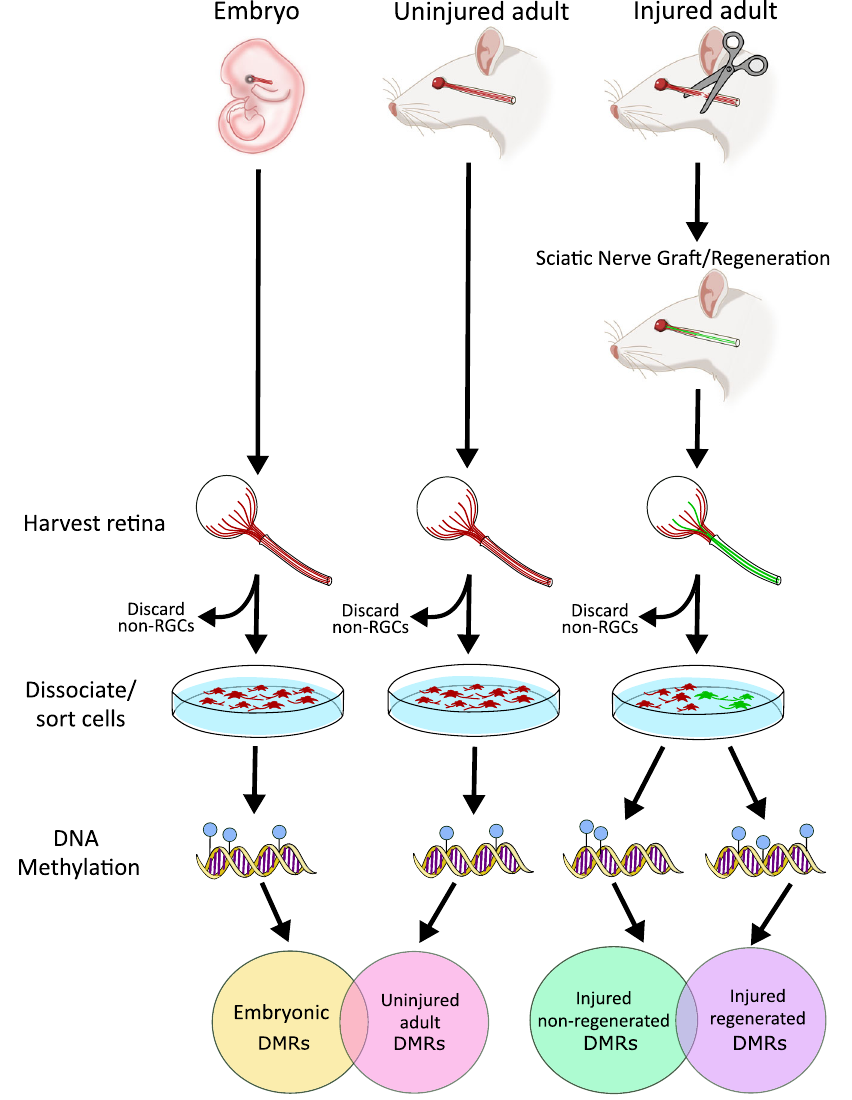
Fig. 1 Overview of the experimental design. A visual fl owchart depicts the overall design of the experiments reported in this article. The fi rst column depicts experiments using uninjured embryo (UE) retinal ganglion cells (RGCs). Embryonic retinas were harvested and dissociated, then FACS-sorted and sorted into RGCs (stained red) and non-RGCs (unstained). The non-RGCs were discarded. DNA was extracted from sorted RGCs and whole-methylome sequencing was performed. The second column depicts experiments using uninjured adult (UA) RGCs. Adult retinas were harvested and dissociated, then FACS-sorted into RGCs (stained red) and non-RGCs (unstained). The non-RGCs were discarded. DNA was extracted from sorted RGCs and whole- methylome sequencing was performed. The third column depicts experiments using injured adult RGCs. See Fig. 2 for details of the surgery, nerve grafting, and fl uorescent staining. The retinas were harvested, dissociated, and FACS-sorted, generating Injured/regenerated (IR; green) and injured/non- regenerated (INR; red) RGCs. DNA was extracted from sorted RGCs and whole-methylome sequencing was performed. Venn diagrams depict DMR overlaps between uninjured adult and embryonic RGCs (left Venn), and between injured regenerated and non-regenerated